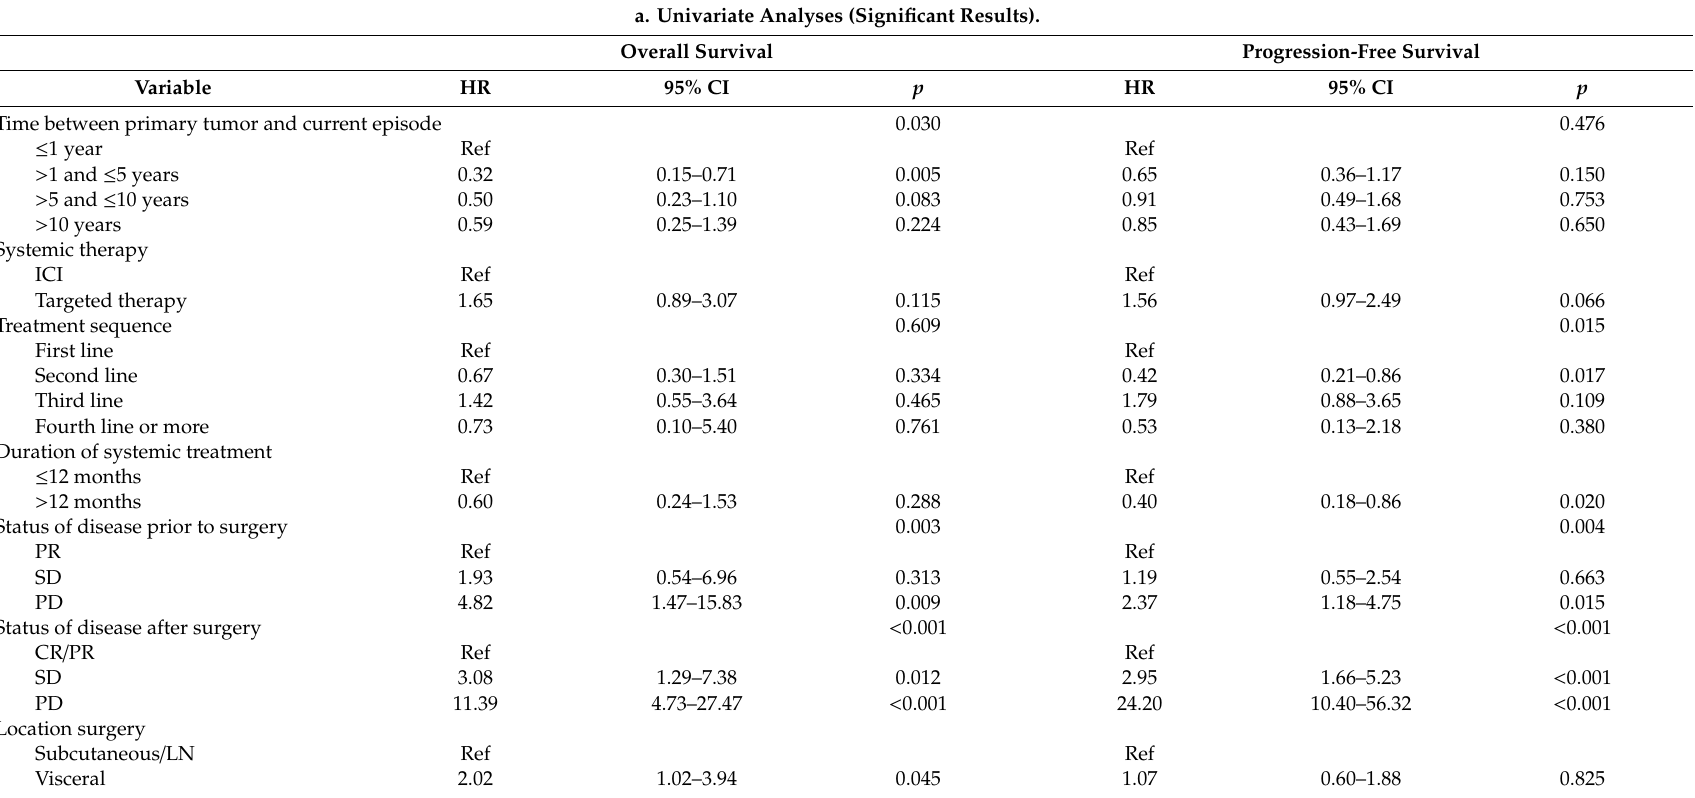
Table 2. ( a ) Univariate analyses (significant results). ( b ) Multivariate analyses. a. Univariate Analyses (Significant